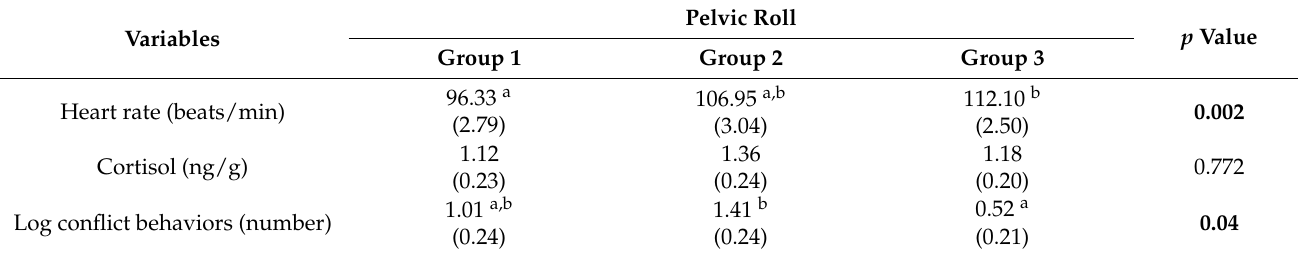
Table 2. Mean values and standard error of the mean for physiological and behavioral variables of the horse according to grade awarded for rider’s pelvic roll ability (Group 1 = poor, Group 2 = medium, Group 3 = good). Cortisol values are average of samples taken at 0 min and 5 min